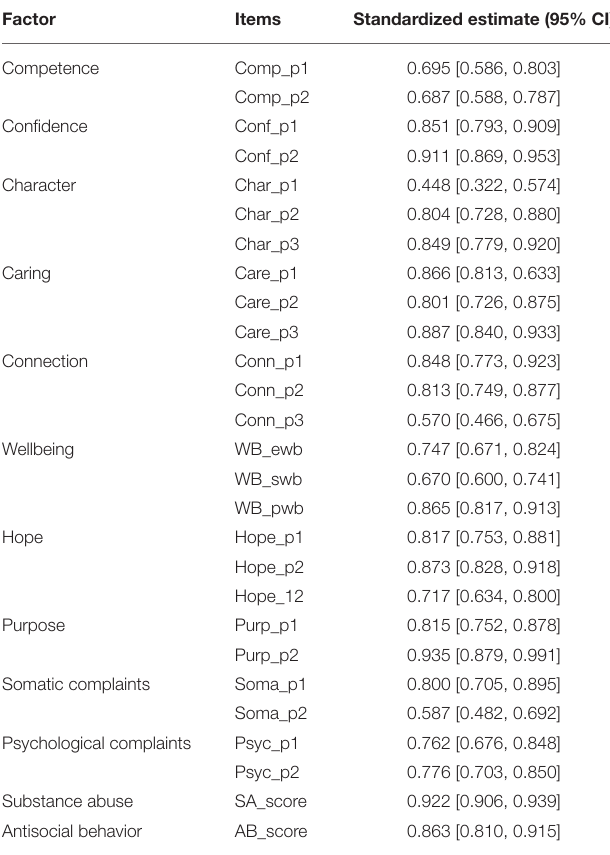
TABLE 1 | Factor loadings and measurement